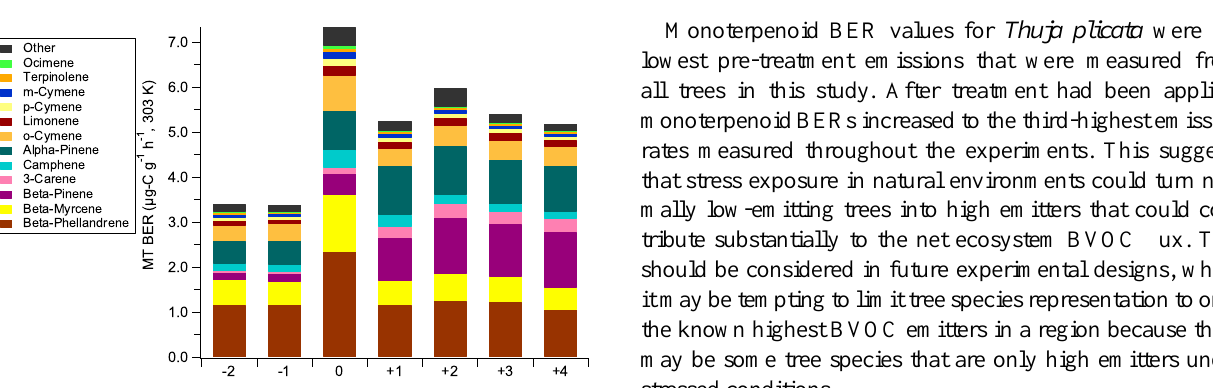
Figure 8. Douglas-fir VOC profile. The x axis denotes the day rela- tive to treatment application. The y axis is the monoterpenoid basal emission rate normalized to